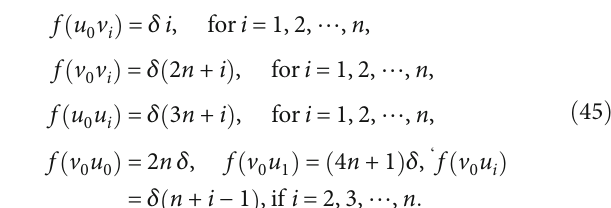
n with ordinary